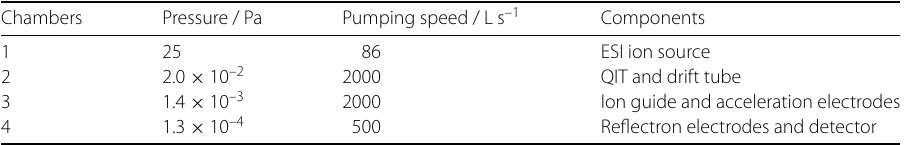
Ion guide and acceleration electrodes